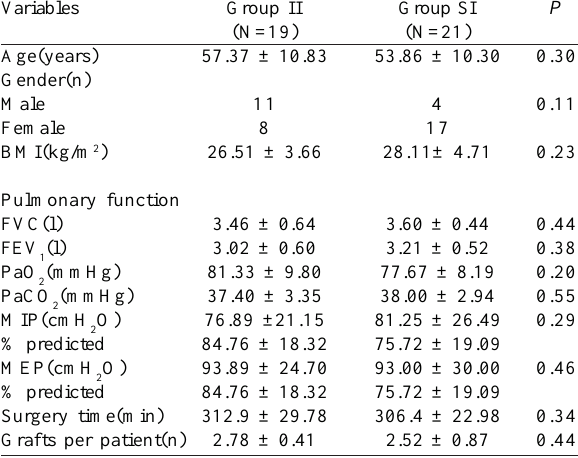
Table 1. Pre and intraoperative clinical and demographic parameters.